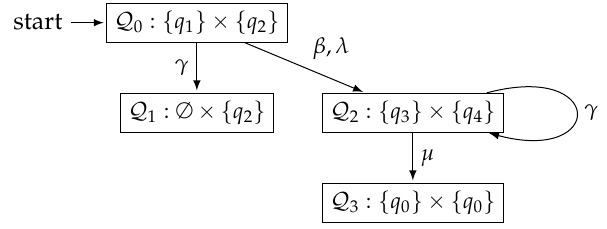
Figure 4. Verifier V ε for G (cid:48) ( q 1 ) and G (cid:48) ( q 2 )